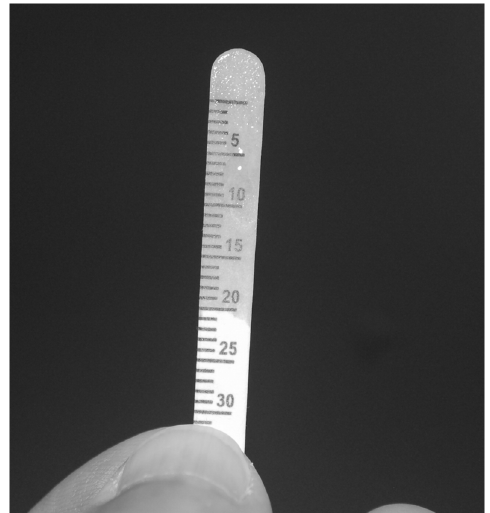
Figure 2. Modified Schirmer test paper strip measurement modality. Fluid amount is measured by the length of the moistened area of the strip in millimeters, i.e., 20 mm.